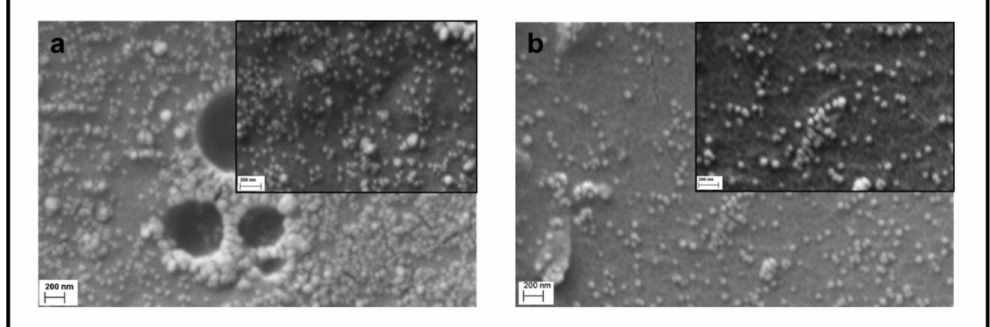
Figure 4. Surface morphology images of films prepared by M.L.1 ( a ) and M.L.5 ( b ) at 76 kX. The inset SEM images were collected at 148